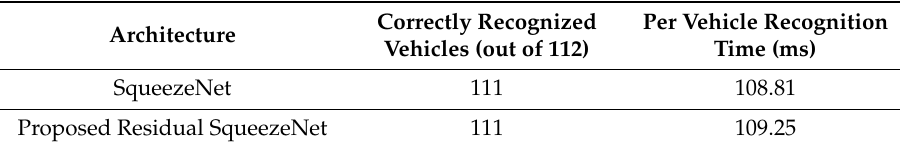
Table 3. Generalization to new data and processing